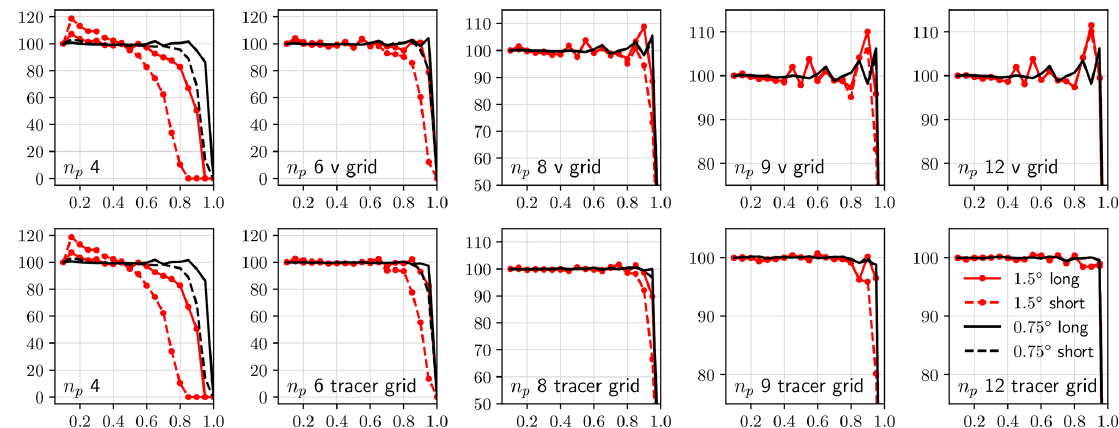
Figure 10. Filament diagnostic following Sect. 3.3 of TS12. Compare with Fig. 5 in TR14. The top row shows the diagnostic measured on the n v p = 4 dynamics grid; the bottom row on the tracer grid. The legend describes the dynamics-grid resolution and the time step length. The prescribed verification problem is the non-divergent flow with cosine bells IC. Property preservation is on. The x axis is τ , the mixing ratio threshold. The y axis is the percent area having mixing ratio at least τ relative to that at the initial time.